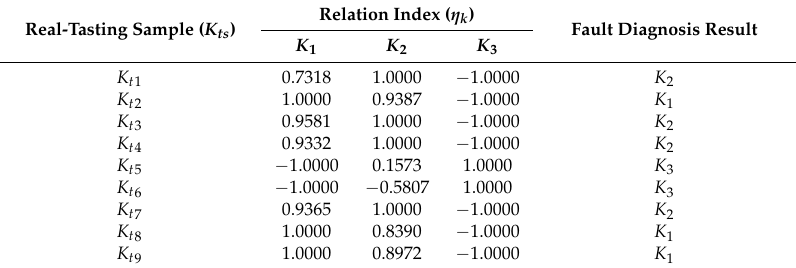
Table 4. Relation indices and fault diagnosis results of the engine